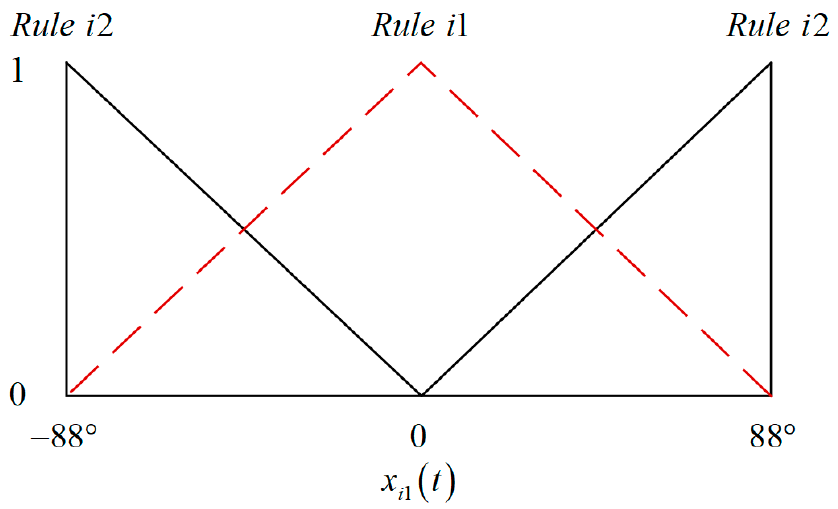
Figure 8. Membership functions for Simulation 4.2.